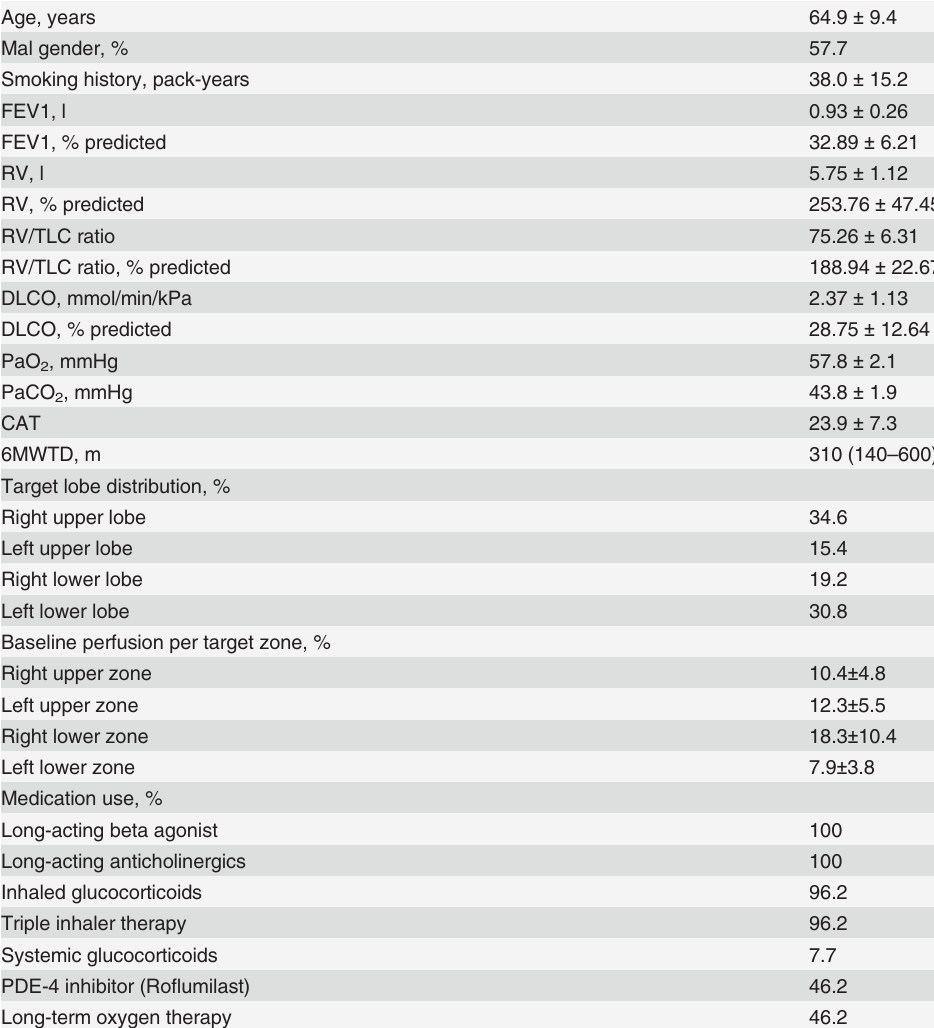
Table 1. Patient demographic and functional characteristics (26 patients).